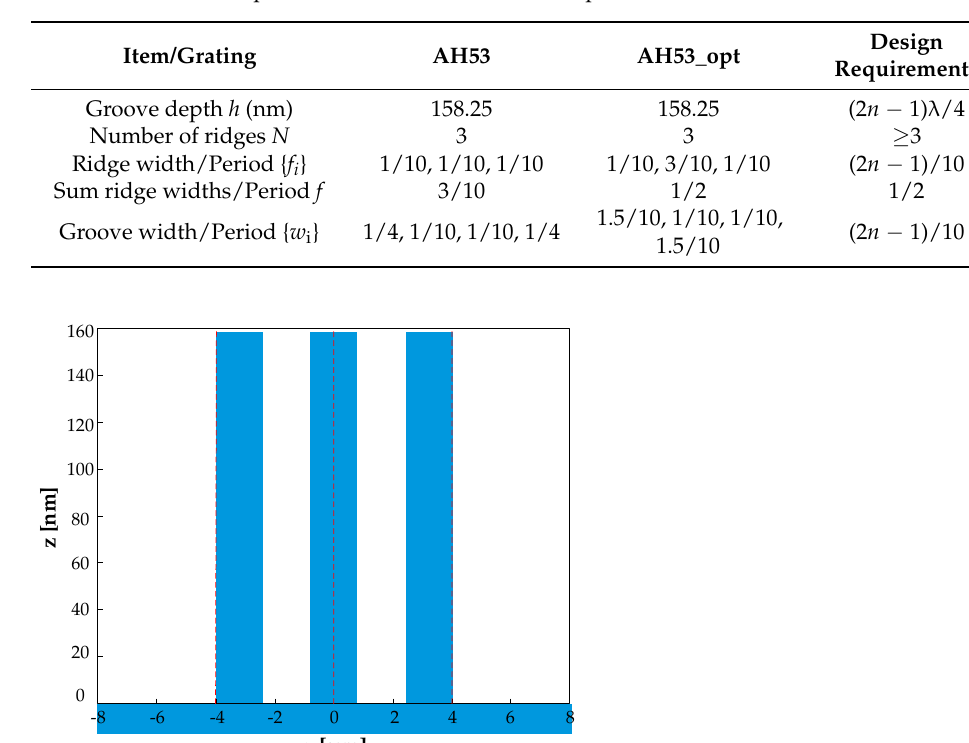
Figure 15. The diffraction efficiency of orders as a function of w 2 . ( a ) The odd orders, ( b ) the even orders. Table 2. The structure parameters of AH53 and AH53_opt.